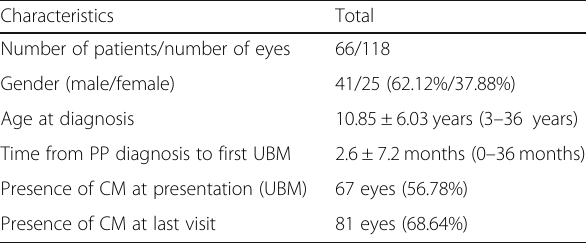
Table 1 Demographic characteristics